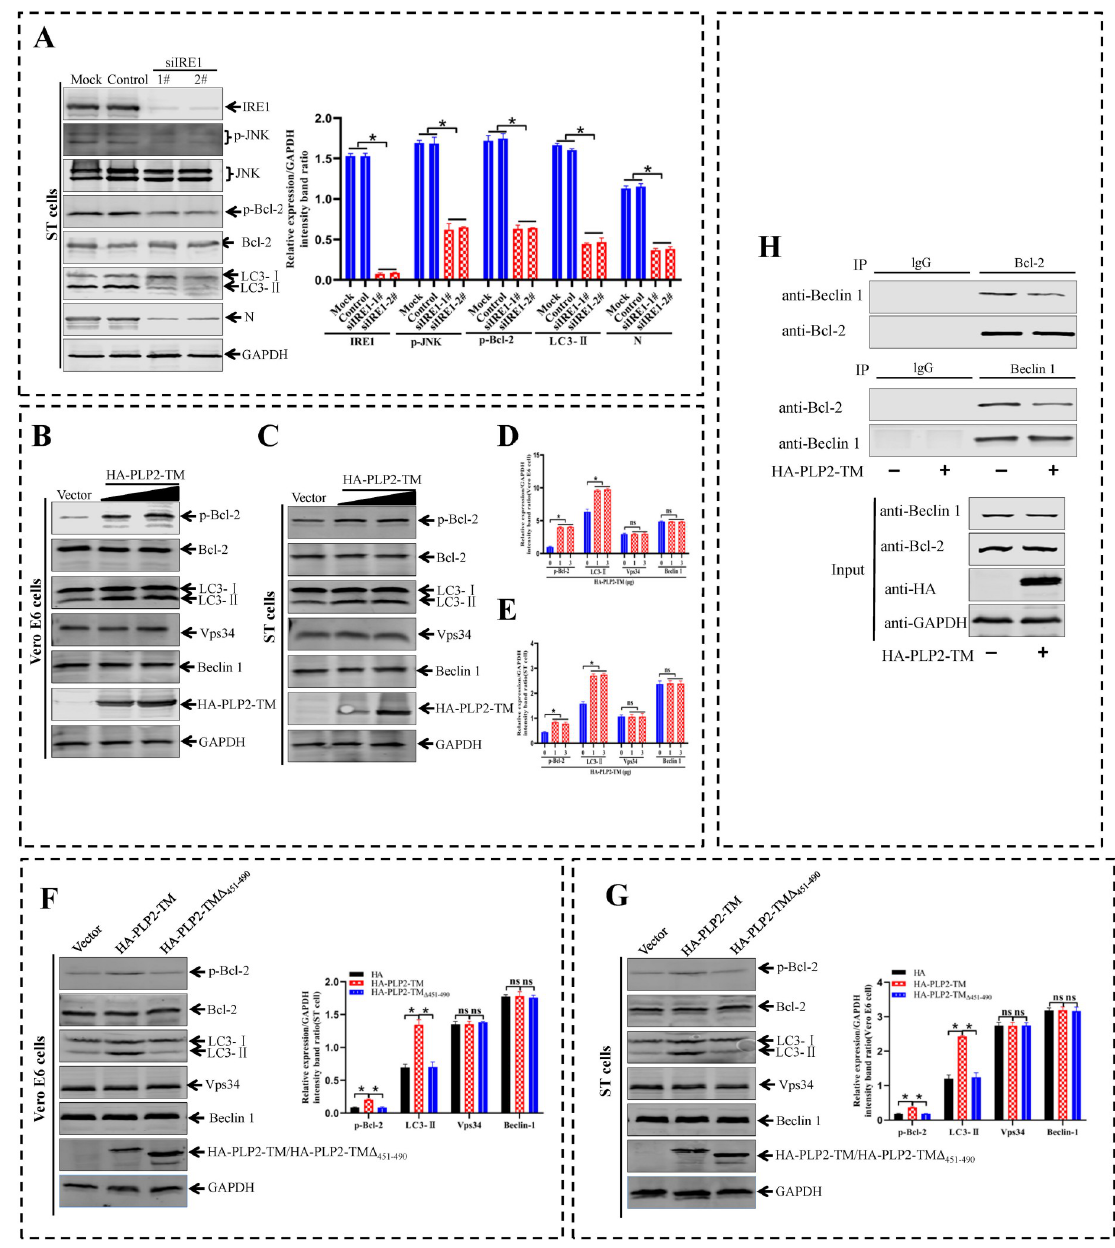
Fig 10. The IRE1-JNK-Beclin 1 signaling pathway is involved in SADS-CoV-induced autophagy. ( A ) ST cells that untreated or treated with Control siRNA or siIRE1 for 48 h, are infected with SADS-CoV for 36 h. A western blotling analysis is performed with the indicated antibodies. Levels of IRE1, p-JNK, p-Bcl-2, LC3-II and SADS-CoV N relative to the level of GAPDH are determined by a densitometric analysis. ( B-E ) Vero E6 ( B and D ) and ST ( C and E ) cells are transfected with increasing doses of pCAGGS-HA-PLP2-TM. At 36 hpi, western blotting is performed with the indicated antibodies. Levels of p-Bcl-2, LC3-II, Beclin 1, and Vps34 relative to the level of GAPDH are determined by a densitometric analysis. ( F and G ) Vero E6 (F) and ST (G) cells are transfected with Vector, HA-PLP2-TM or HA- PLP2-TM Δ 451–490. At 36 h post-transfection, western blotting is performed with the indicated antibodies. Levels of p-Bcl-2, LC3-II, Beclin 1, and Vps34 relative to the level of GAPDH are determined by a densitometric analysis. ( H ) HEK293T cells are transfected with pCAGGS- HA-PLP2-TM or empty vector. At 36 h post-transfection, cell lysates are subjected to immunoprecipitation with anti-Bcl-2 or anti-Beclin 1 antibodies, and subsequent immunoblotting with anti-Beclin 1 or anti-Bcl-2 antibodies. Means and SD (error bars) of three independent experiments are indicated ( � P <